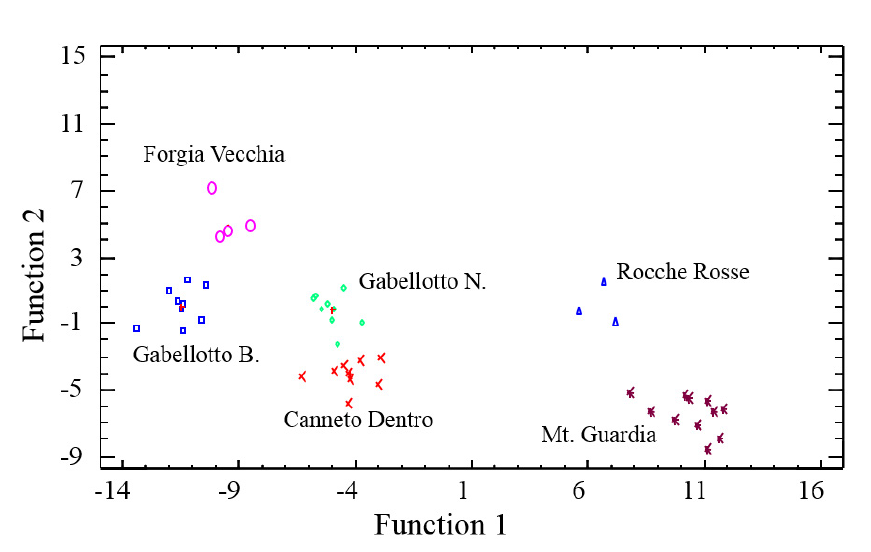
Figure 12. Discriminant function graph of prehistoric and historic Lipari subsources by